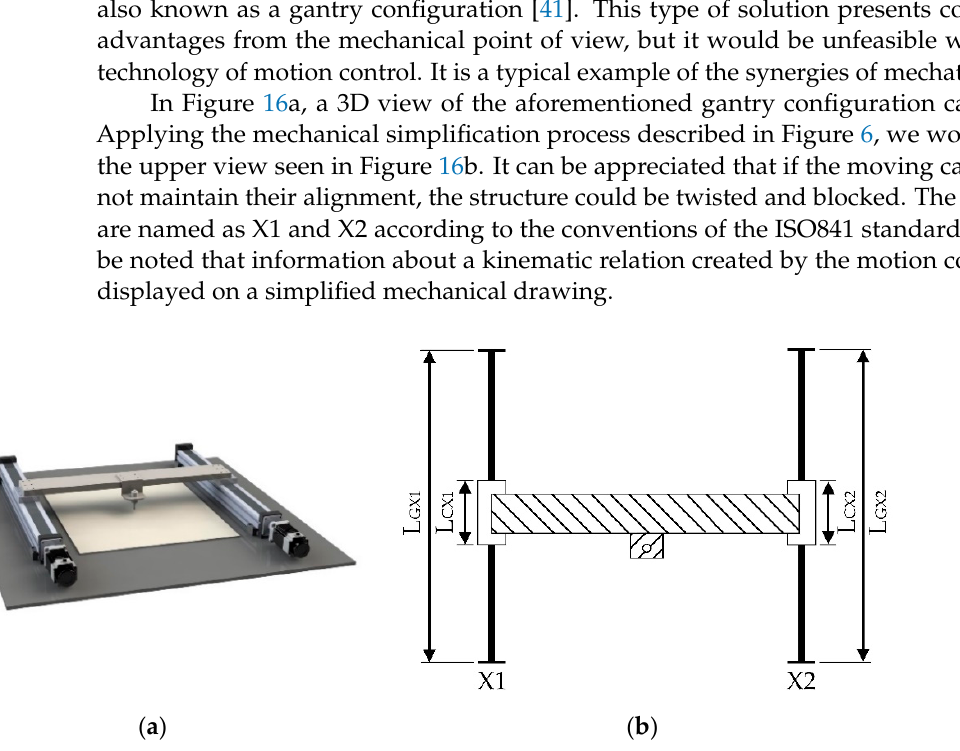
a “=“ sign, the name of the master servo axis, and the motion relation.